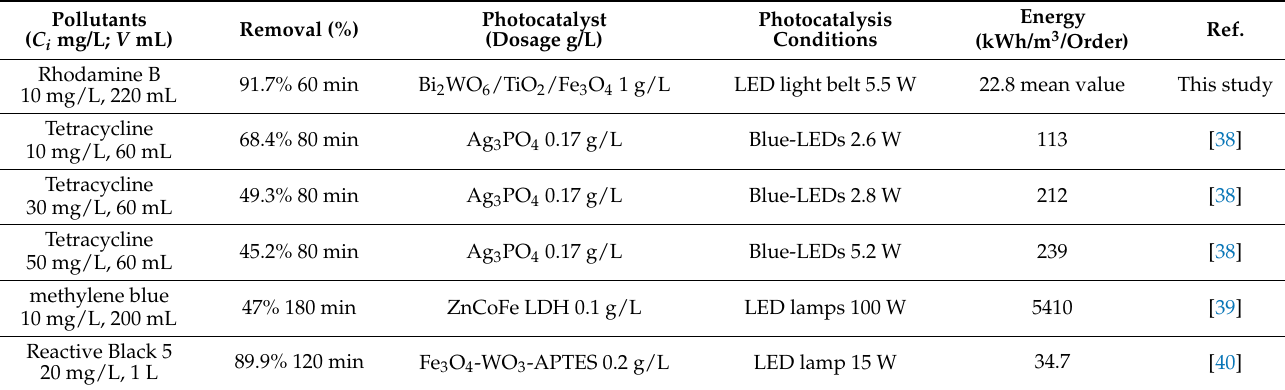
Table 1. Comparison of electrical energy consumption of different photocatalytic degradation